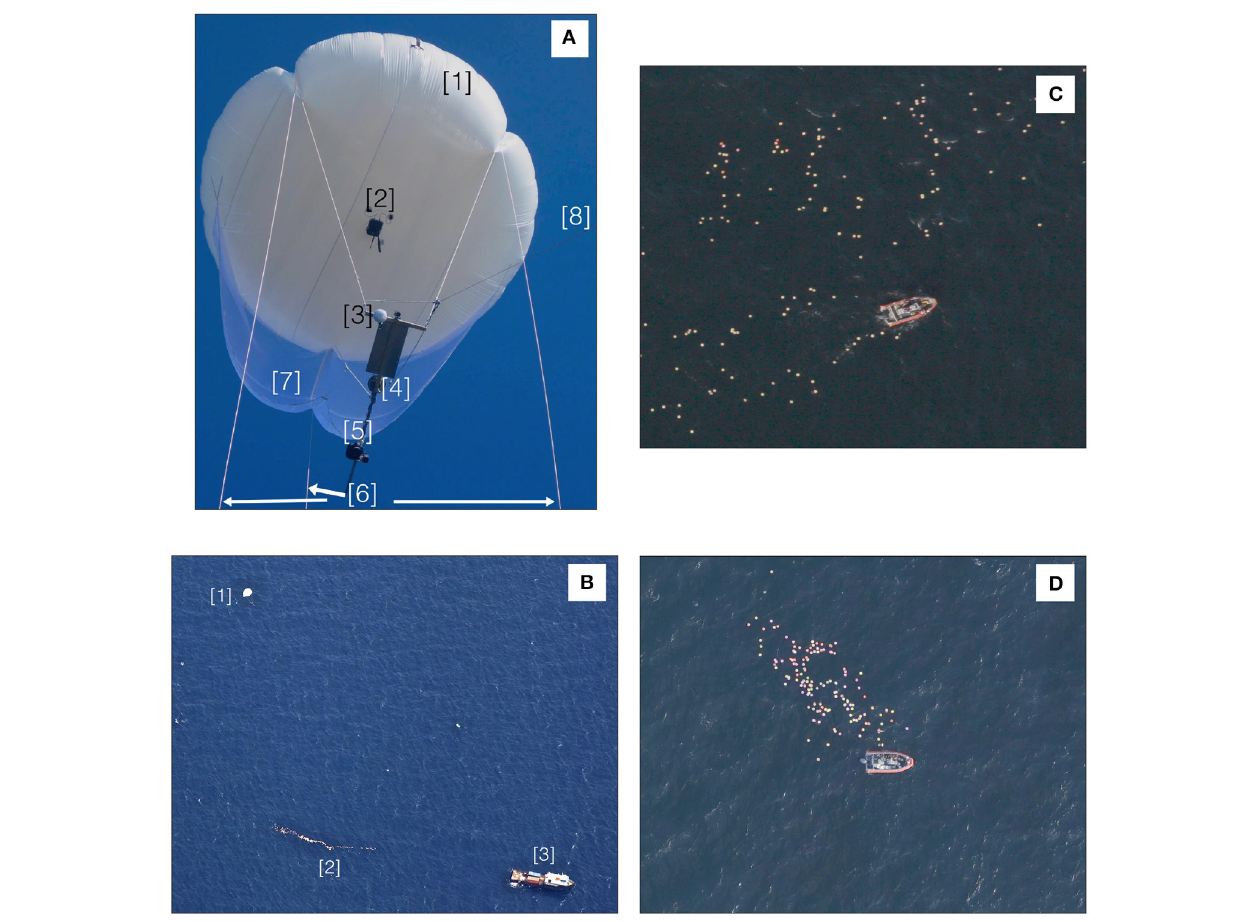
FIGURE 1 | (A) STARSS consists of large aerostat (1), an emergency deflation device (2), a 5 GHz WiFi bridge (3), a NovaTel GNSS antenna (4), a 50.6 megapixel Canon 5DSR Mk III DSLR and INS (5), handling lines for launch and recovery (6), a sail (7), and a tether (8). The onboard computer and batteries were stored in a waterproof case on the top of the instrument frame (not visible). (B) An aerial image of a STARSS dispersion experiment. STARSS (1) is positioned over a patch of bamboo plates (2) and is tethered to the tender vessel (M/V Masco VIII; 3). (C) A grid deployment. (D) A patch